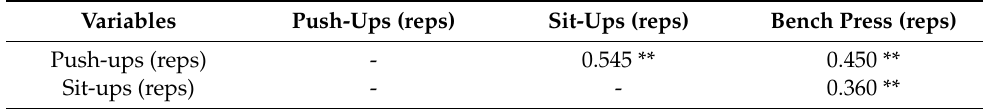
Table 4. Correlations between Muscular Endurance Variables at Week 7. Variables Push-Ups (reps) Sit-Ups (reps) Bench Press (reps) Push-ups (reps) - 0.418 ** 0.353 ** Sit-ups (reps) - - 0.381